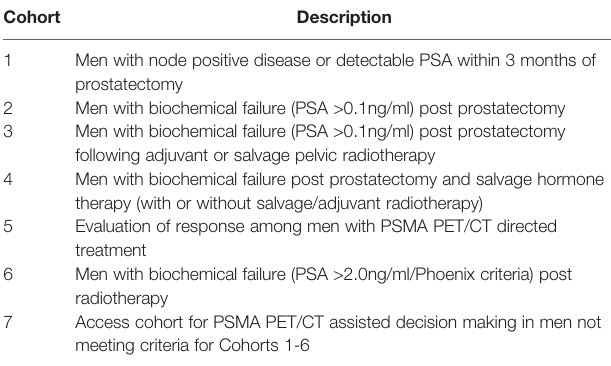
TABLE 1 | PREP Registry